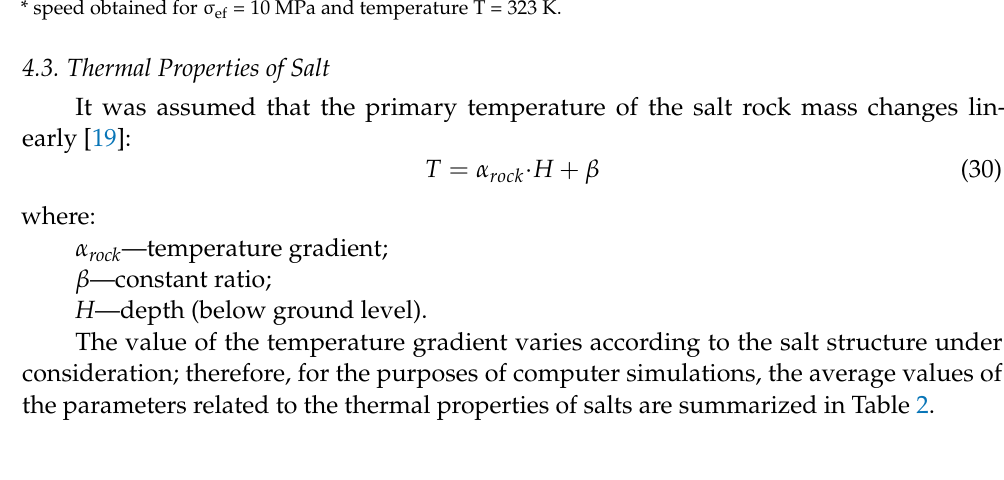
Table 1. The adopted values of the coefficients for the two creep laws. Model A (‰) Q/R (K) N d ε /dt * (‰/day) Slow-creep Law (SCL) 219.65 6500 4 0.004 Fast-Creep Law (FCL) 175.72 6500 5